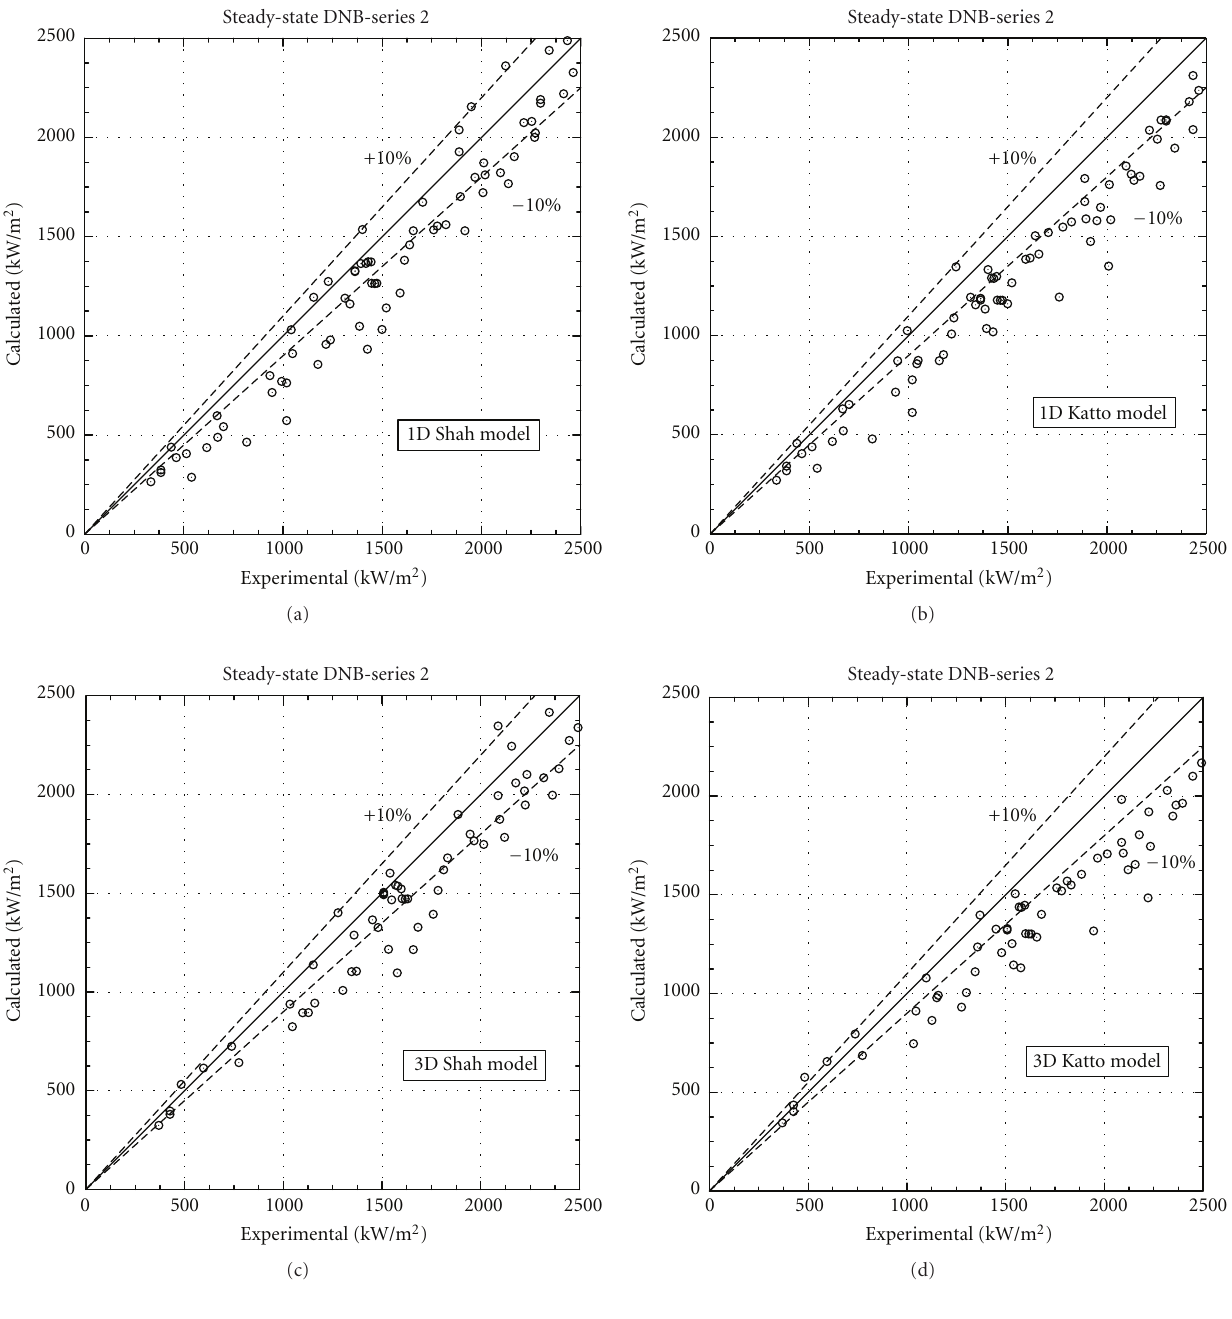
Figure 8: Computed versus experimental critical heat fluxes (Series